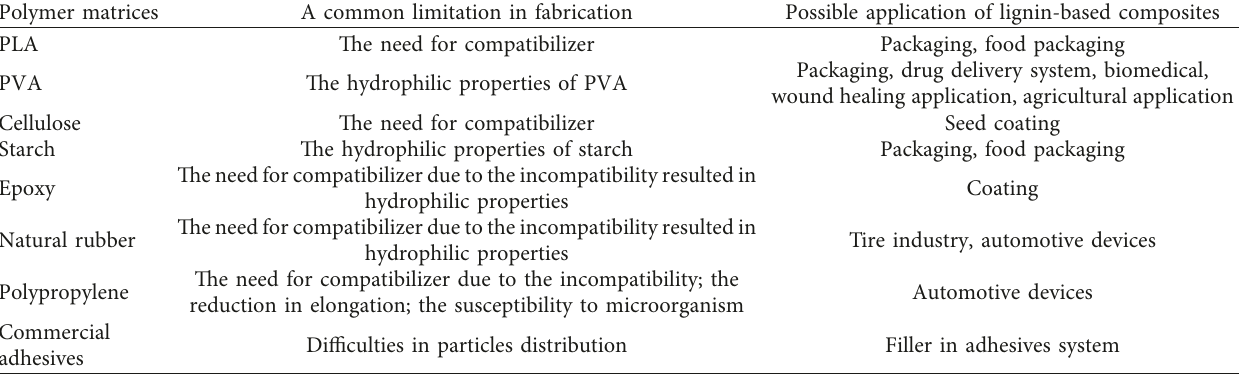
Table 2: Description of lignin as filler in lignin-based